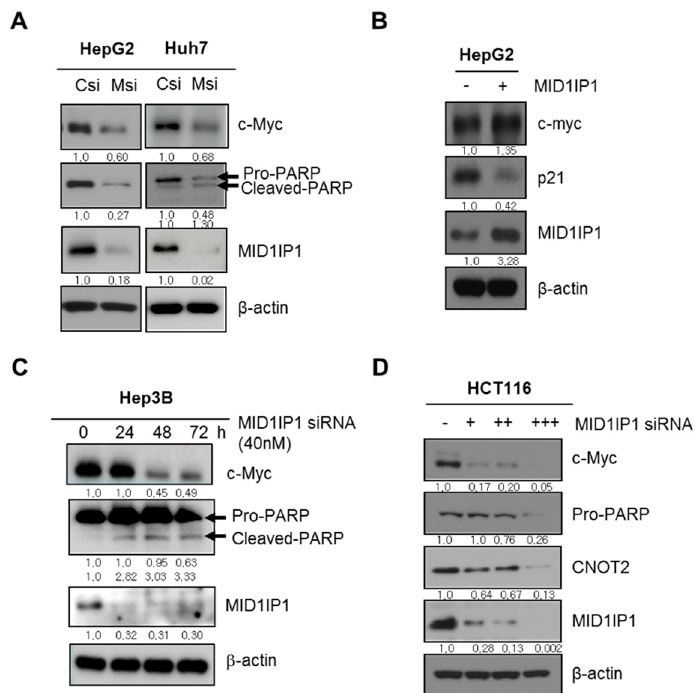
Figure 3. MID1IP1 depletion attenuates the expression of pro-PARP, c-Myc and CNOT2 and activates p21 in several cancers. ( A ) Effect of MID1IP1 depletion on pro-PARP (116 kDa), cleaved-PARP (89 kDa), MID1IP1 and c-Myc in HepG2 and Huh7 cells. HepG2 and Huh7 cells transfected with MID1IP1 siRNA (Msi) or negative control siRNA (Csi) were cultured for 72 h and then were subjected to Western blotting with antibodies of pro-PARP, MID1IP1, c-Myc and β -actin. ( B ) Effect of MID1IP1 overexpression on MID1IP1, c-Myc and p21 in HepG2 cells. HepG2 cells transfected with MID1IP1 overexpression plasmid (+) and pcDNA3.0 control vector ( − ) were cultured for 72 h and then were subjected to Western blotting with antibodies of MID1IP1, c-Myc and p21. ( C ) Effect of MID1IP1 depletion on MID1IP1, pro-PARP (116 kDa) and cleaved-PARP (89 kDa) in Hep3B cells. ( D ) Effect of MID1IP1 depletion on MID1IP1, c-Myc, pro-PARP and CNOT2 in HCT116 cells. Concentrations of MID1IP1 siRNA; + (20 nM), ++ (40 nM), +++ (80 nM). Values of Western blot images represent relative level of protein expression/ β -actin. Western blotting was conducted in triplicates.